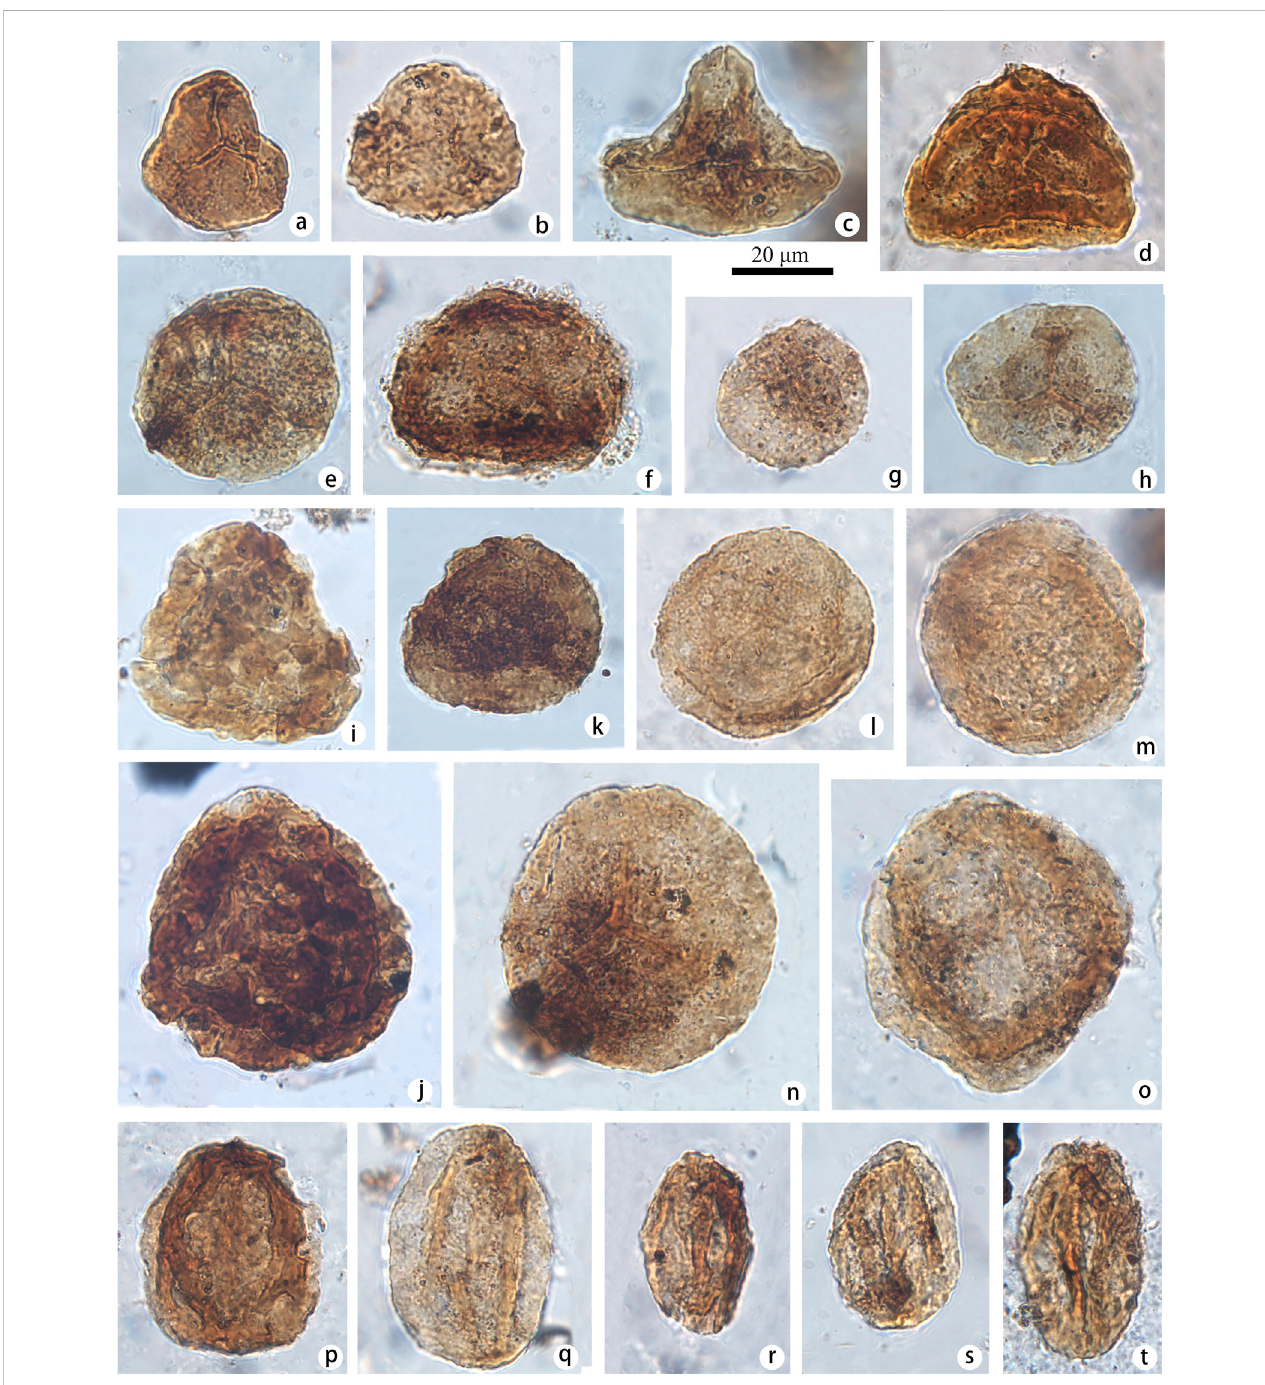
FIGURE 2 Selectedsporesand pollenidenti fi edattheYunmeng pro fi le (taxonnamefollowedbysamplenumber andposition in England fi nder inparentheses). (A) Cyathidites minor (Couper, 1953) (a-STYM94, J11-2); (B) Converrucosisporites decoratus (Shang, 2011) (b-STYM48, R17-4); (C) Dictyophyllidites harrisii (Couper, 1958) (c-STYM48, N34-3); (D) Duplexisporites rotundatus (Shugaevskaya, 1969) (d-STYM01, N41-4); (E) Verrucosisporites rotundus (Singh, 1964) (e-STYM03, N23-3); (F) Kraeuselisporites spinosus (Jansonius, 1962) (f-STYM16, F20-1); (G) Apiculatisporites bulliensis (Helby et De Jersey, 1972) (g-STYM94, R8-3); (H) Lundbladispora playfordi (Balme, 1963) (h-STYM12, I26-1); (I) Asseretospora gyrata (Playford et Dettmann) (Schuurman, 1977) (i-STYM16, B21-4); (J) Asseretospora curvata (Qu, 1980) (j-STYM28, J12-2); (K) Lundbladispora watangensis (Qu, 1984) (k-STYM12, R36-2); (L, M) Lundbladispora subornata (Ouyang and Li, 1980) (l-STYM01, O45-2; m-STYM01, U25-4); (N) Lundbladispora communis (Ouyang and Li, 1980) (n-STYM94, K17-3); (O) Lundbladispora sp. (o-STYM01, M26-4); (P) Aratrisporites exiguous (Qu, 1984) (p-STYM28, M31-2); (Q) Aratrisporites tenuispinosus (Playford, 1965) (q-STYM01, N37-1); (R) Aratrisporites coryliseminis (Klaus, 1960) (r-STYM01, N37-1); (S, T) Aratrisporites granulates (Klaus) (Playford and Dettmann, 1965) (s-STYM21, R45-4, t-STYM01,